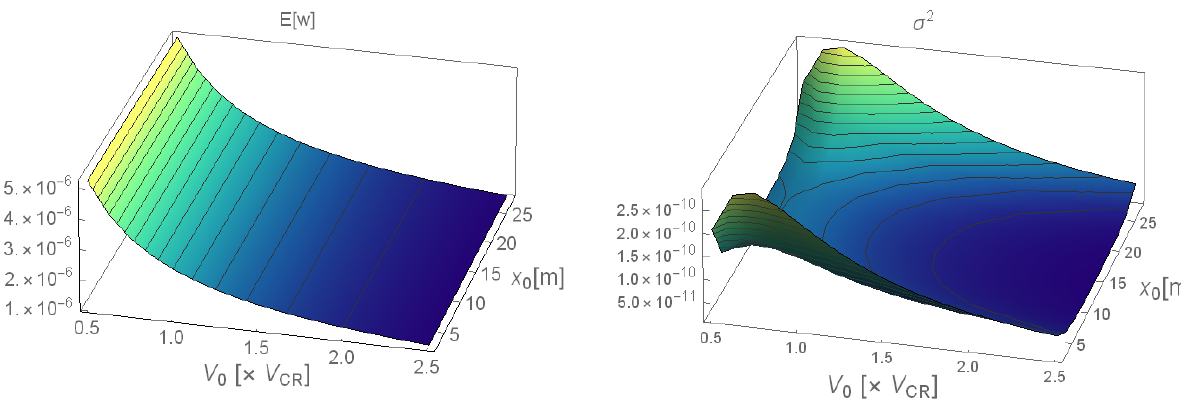
Figure 10: Deflections in the midspan for different locations of the absorber: (a) the expected value and (b) the